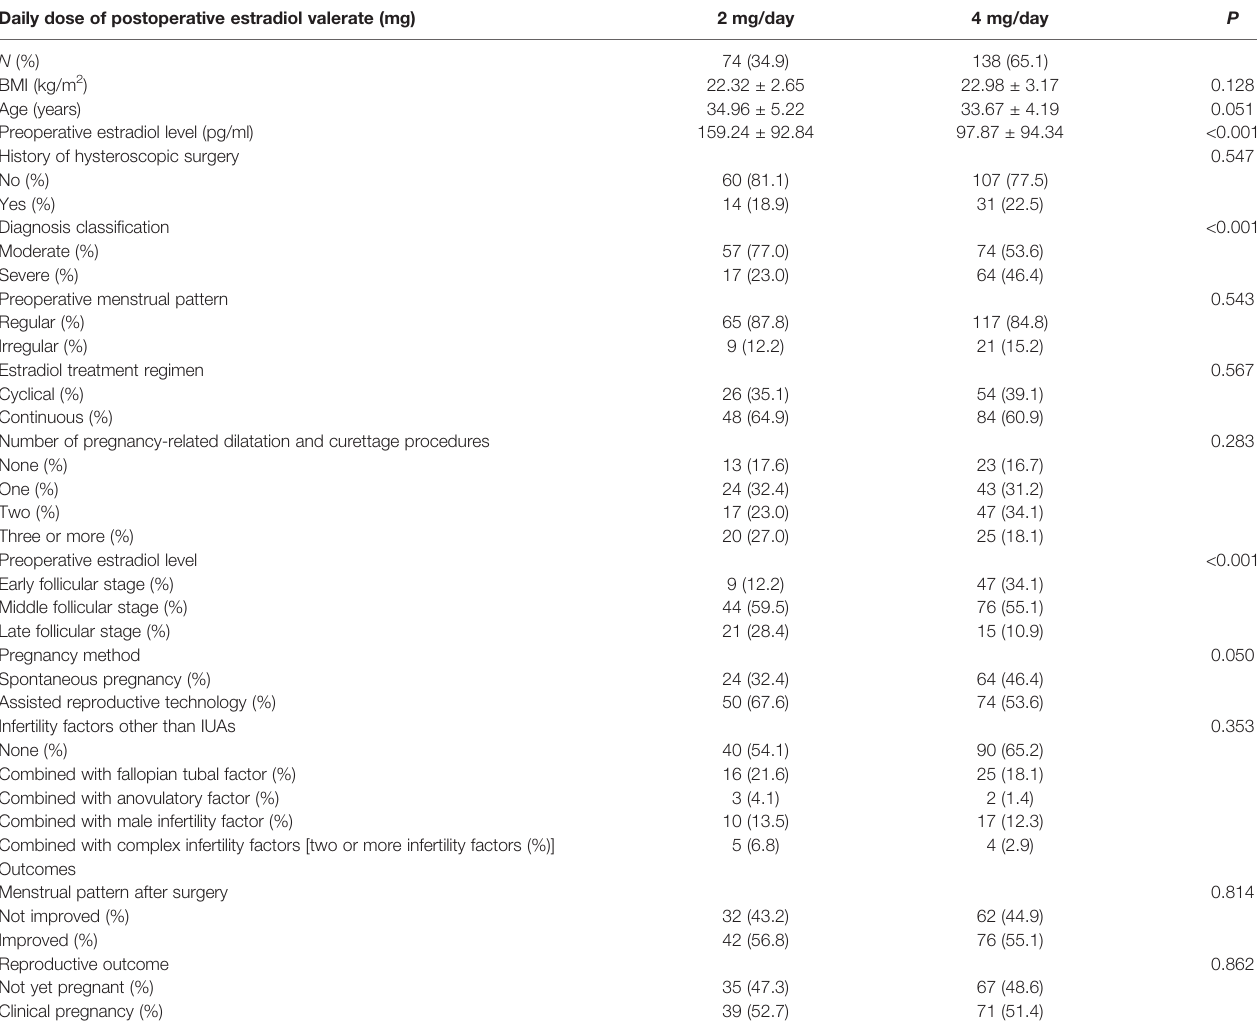
TABLE 1 | Characteristics of the study population. Daily dose of postoperative estradiol valerate